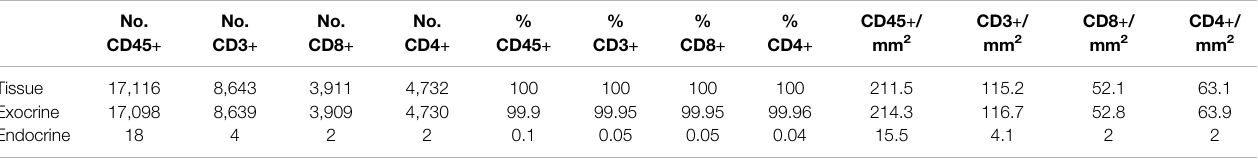
TABLE 3 | Number, proportion and density of immune cells in the whole tissue, the exocrine and endocrine area. CD45+ cell values correspond to the analysis of slide #1, and CD3+, CD8+, and CD4+ cell analysis to slide #6. No. CD45